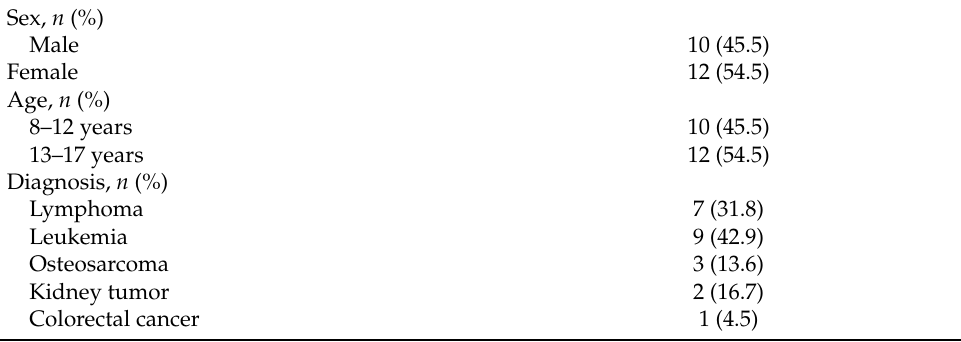
Table 1. Demographic and clinical characteristics of participants ( n =